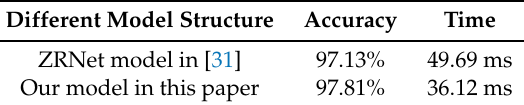
Table 2. The influence of model structure.